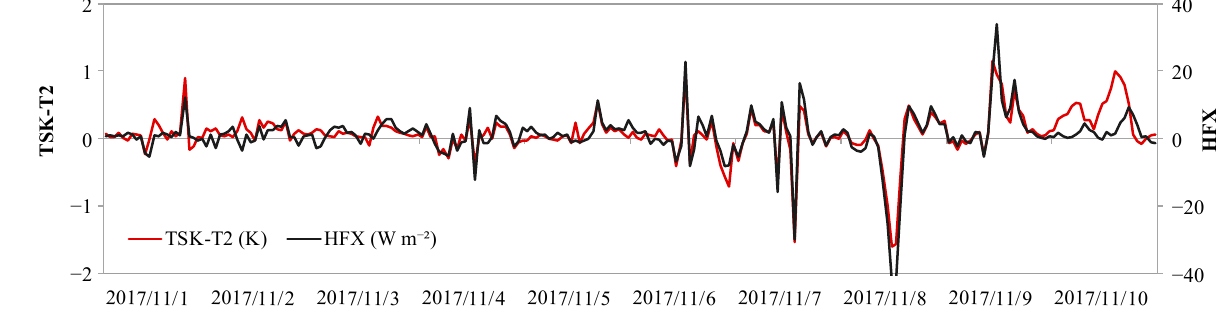
Figure 8. E ff ects of the high-resolution UF and UM on the vertical distribution of the simulated heat exchange coe ffi cient in the underlying surface layers of the Tianhe District during the daytime (( a ) 12:00 LST) and night-time (( b ) 20:00 LST). The heat exchange was is calculated online with the simulation and outpu tt ed by the WRF model.